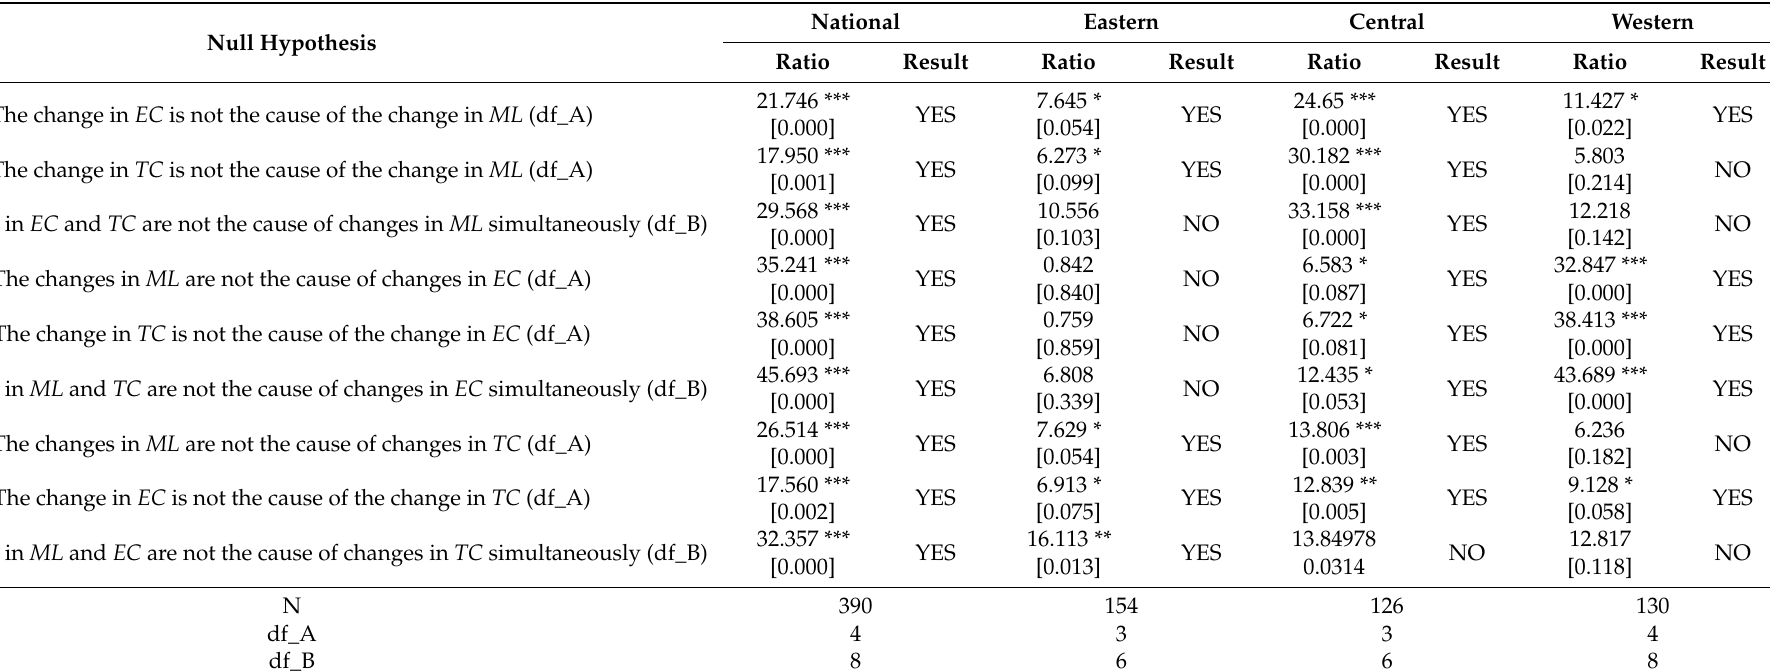
Table 8. Results of Granger Causality